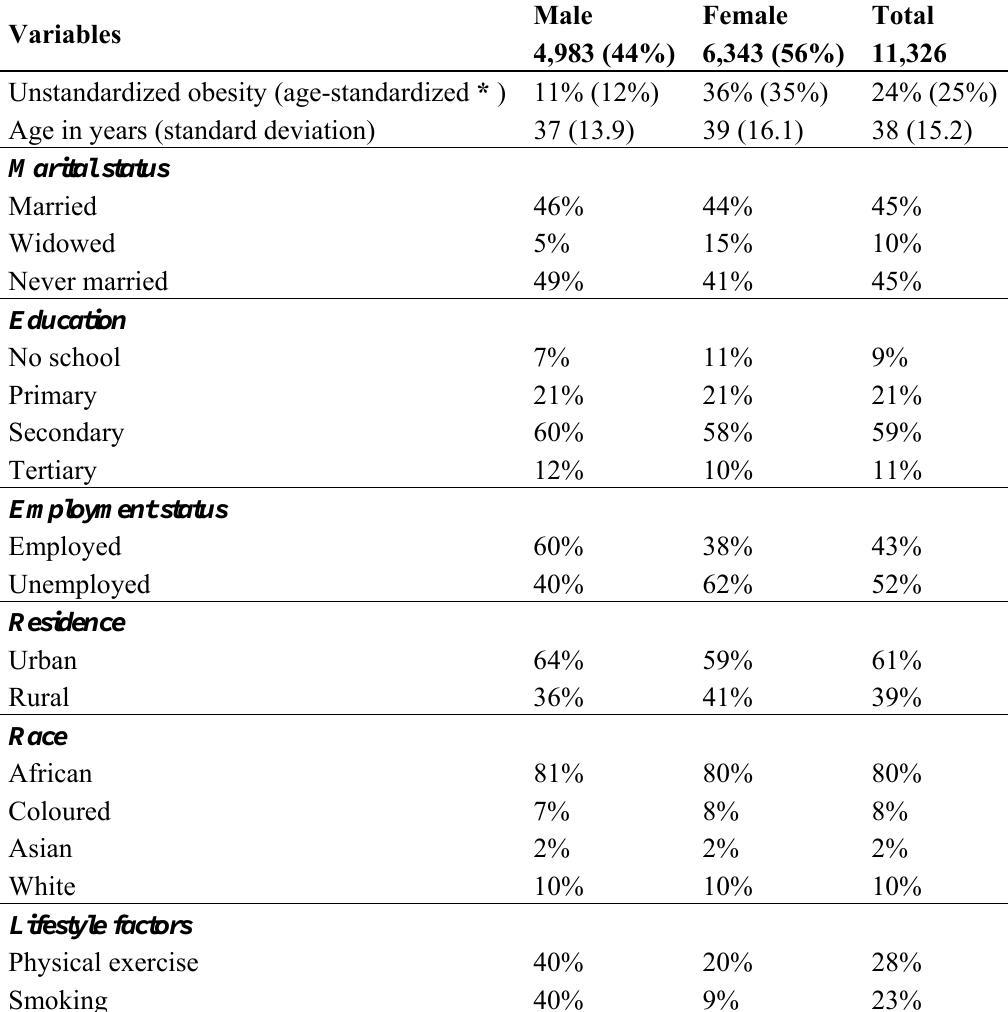
Table 1. Socio-demographic characteristics, health and lifestyle